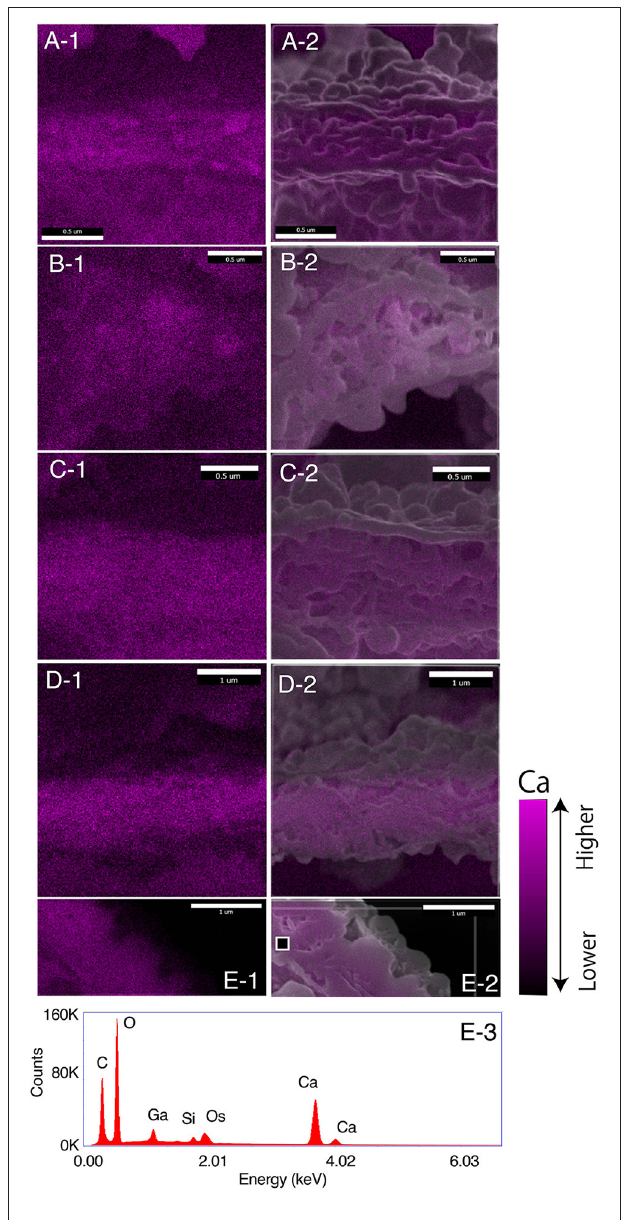
FIGURE 8 | EDS results on the SOC for specimens #1 to #5. (A–E) corresponding to specimen #1 to #5. − 1, calcium distributions; − 2, calcium image superimposed on the SEM image. The brightness of calcium distribution shows the intensity of calcium signal as legend of the bottom right. E-3, EDS spectrum of spot measurement on the black square on E-1 of specimen